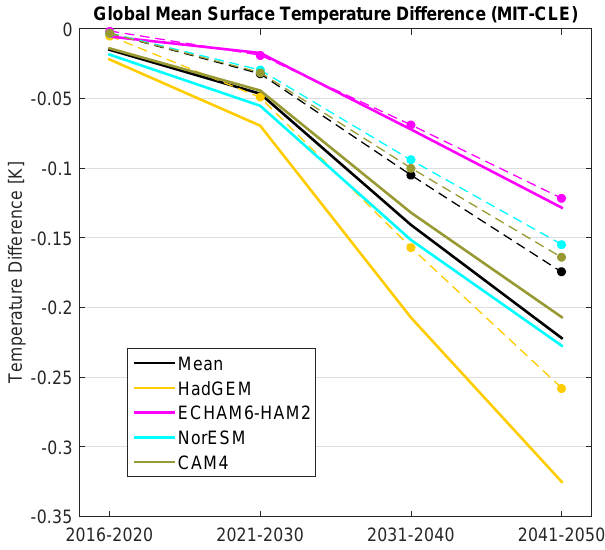
Figure 19. Time evolution of difference in global-mean surface temperature for the MIT and CLE scenario calculated with the ARTP-based method. Solid lines are the total difference (MIT– CLE), while the dashed lines give the responses to CH 4 mitigation only. The solid lines can be compared directly with the results from the transient model simulations shown in Fig.